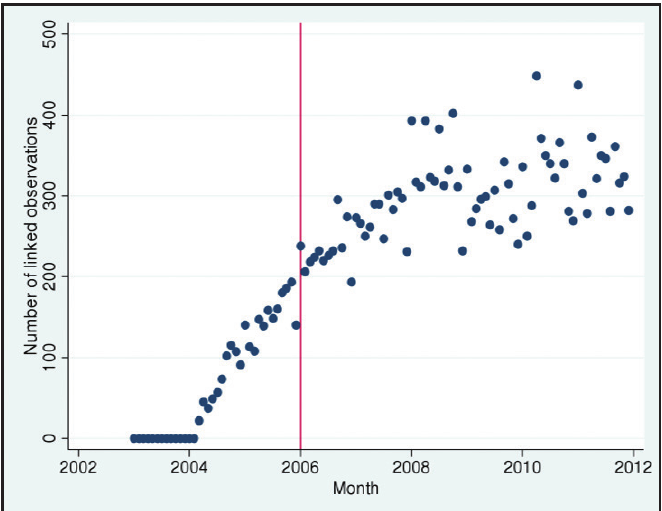
Number of linked workers over